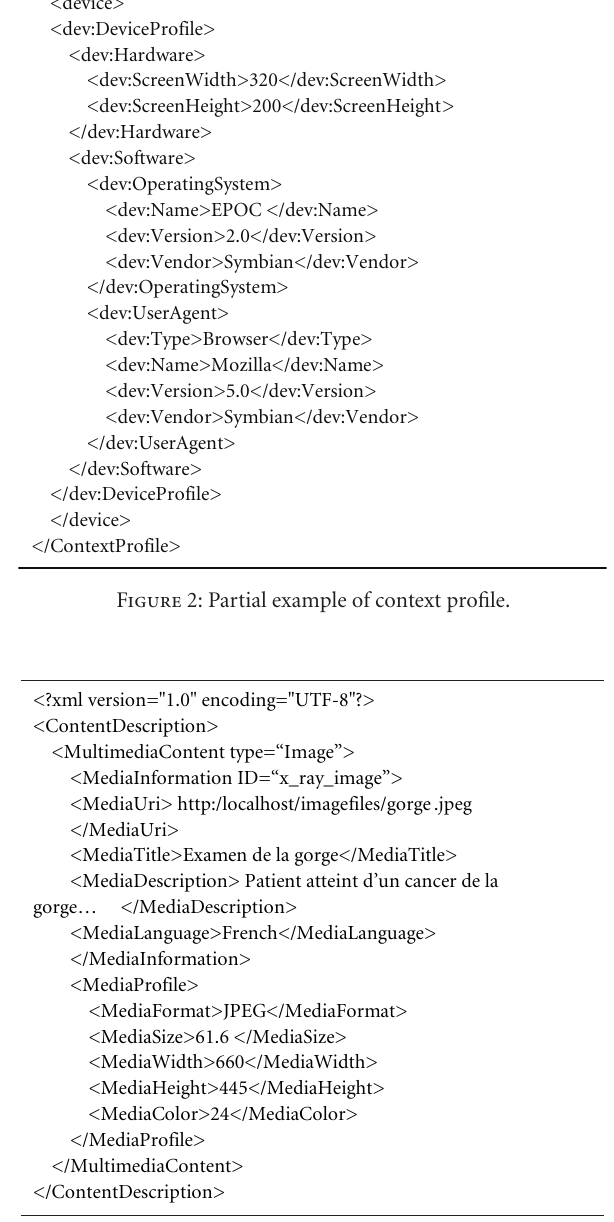
Figure 3: Sample multimedia content description using MPEG-7